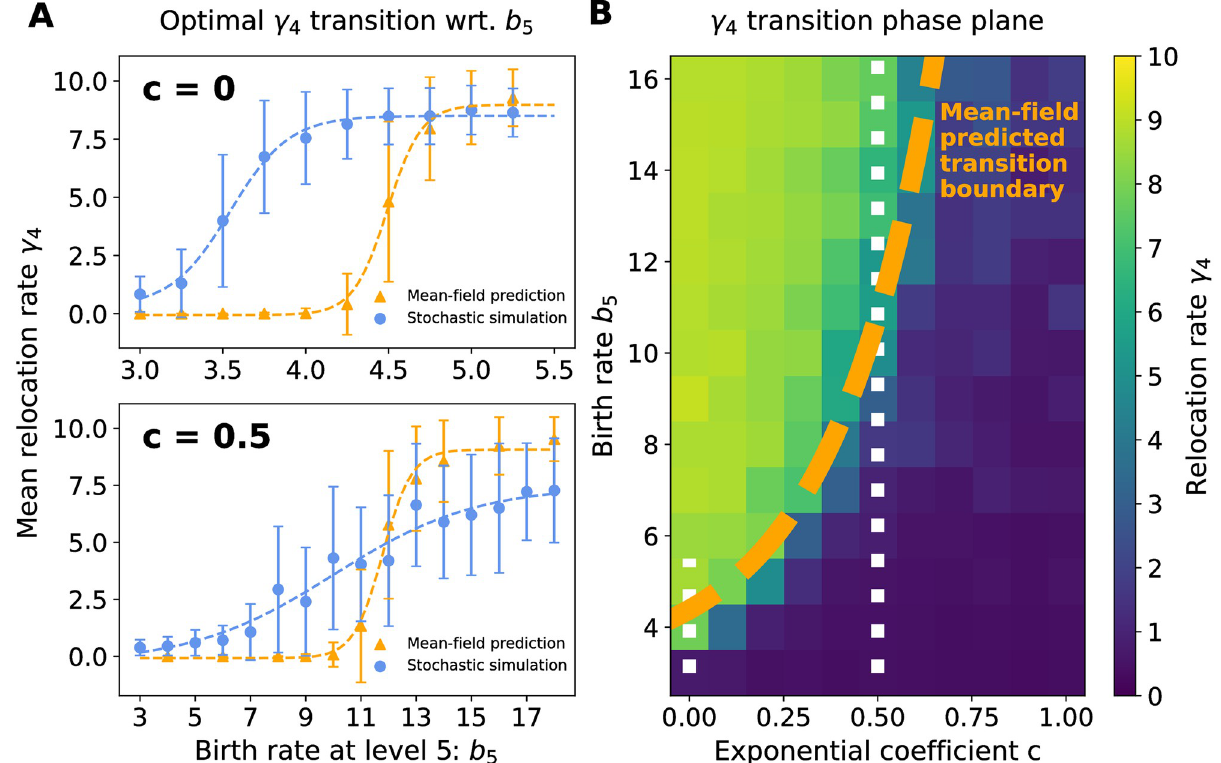
Fig 3. The most competitive phenotypes are shaped by the rarity of the highest-resource sites. The abundance of the five resource levels distributed with frequency w / e − ck , where k 2 {1, 2, 3, 4, 5} and the exponential coefficient c determines the rarity of levels. The most competitive phenotype k changes as a function of birth rates and resource rarity: A, top. For resources drawn from discrete uniform distribution ( c = 0), the fourth component of the most competitive phenotype γ 4 transitions from low to high as the birth rate b 5 increases. All other phenotype components remain steady as γ 1,2,3 ! γ max and γ 5 ! γ max . The agent-based stochastic simulation and the mean-field prediction transitions are qualitatively similar, though the transition occurs at different values of b 5 . A, bottom. A similar transition in γ 4 occurs for a resource distribution with exponential coefficient c = 0.5, which has rare high resource level sites. The transition persists but at a higher birth rate b 5 . B. A heatmap plot of the fourth phenotype component γ 4 as a function of the exponential coefficient c and the birth rate b 5 . The orange dashed line is the predicted transition boundary from the mean-field model, where γ 4 = 5 maximizes the effective fitness function derived in the low-density limit. The two white dotted lines show the range of b 5 for c = 0 and 0.5 in panel